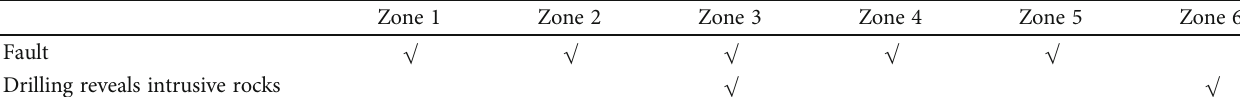
Table 1: The di ff racted wave attribute of igneous compared with fault interpretation and logging